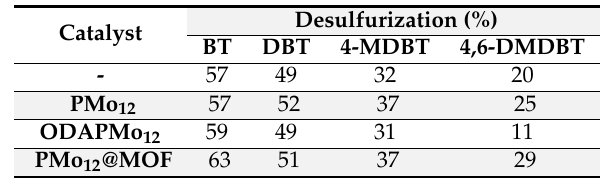
Table 1. Results obtained for the initial extraction of each refractory sulfur compound from the model diesel to the extractant phase using PMo 12 , ODAPMo 12 and PMo 12 @MOF catalysts. Desulfurization (Des) was determined considering the initial sulfur concentration in diesel (Sinitial): Des=(Sinitial-S)/Sinitial x